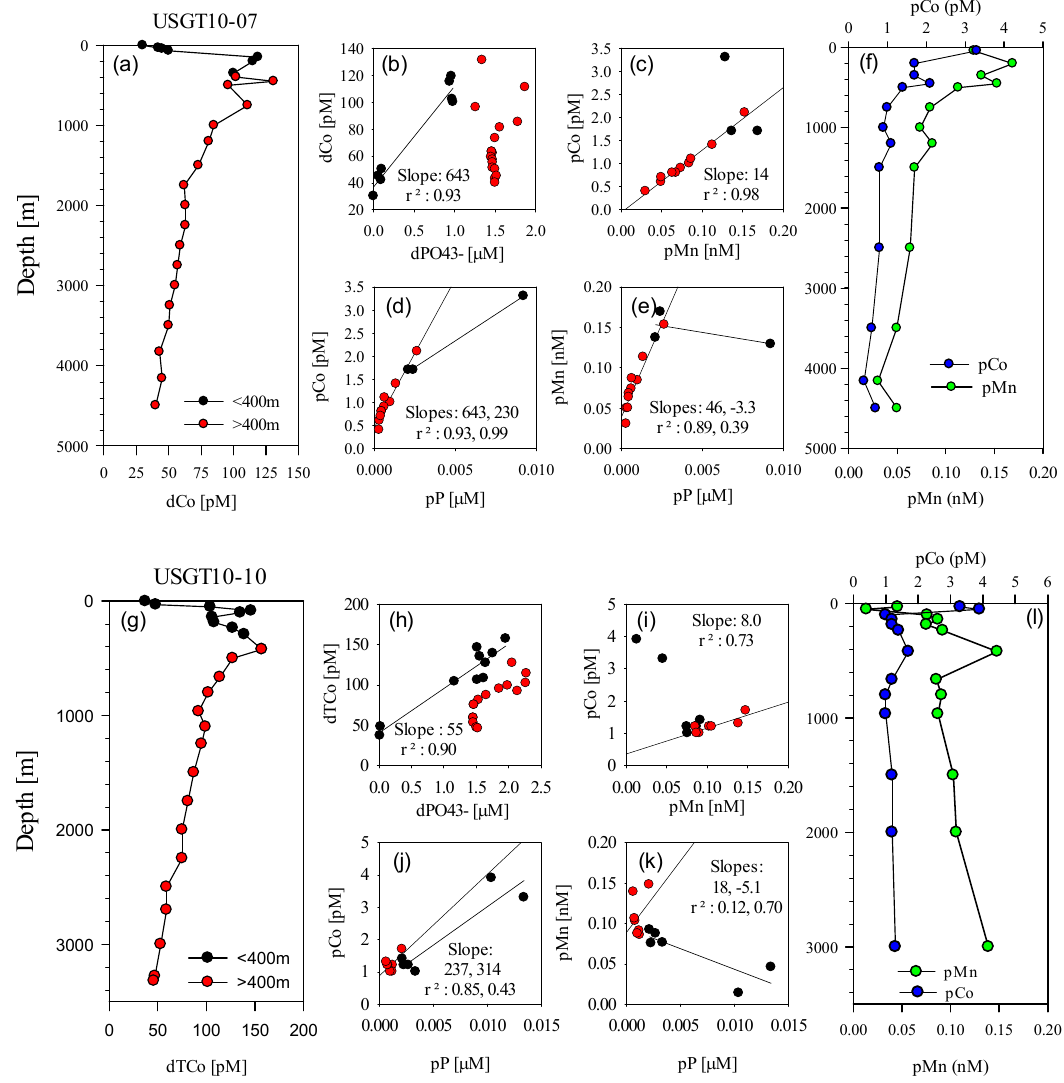
Figure 12. Dissolved and particulate Co and associations with P and Mn from selected stations (USGT10-7 and 10-10) from the GA03/3_e expedition and comparisons of dissolved Co and dissolved phosphate (b, h) , particulate Co and particulate Mn (c, i) , particulate Co and particulate P (d, j) , and particulate Mn and particulate P (e, k) are shown. dCo and phosphate. dCo and phosphate showed linear relationships above 400m (b, h) , while p Co and p Mn were related below 400m (c, i) , consistent with a transition between uptake and remineralization dominance (<400m) and scavenging by manganese oxides (>400m), and the profile vertical structure (a, g)